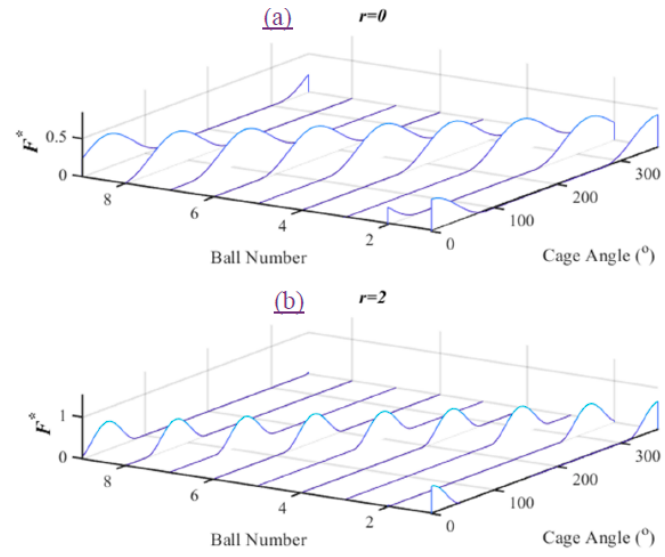
Figure 4. Load distribution for each element ( a ) clearance ratio r = 0 and ( b ) r = 2.